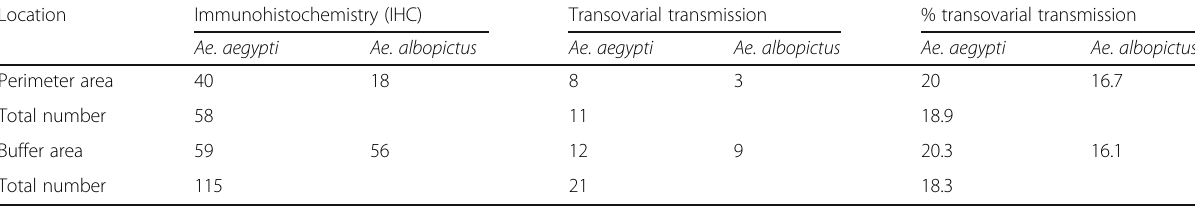
Table 2 Analysis of transovarial transmission of Aedes spp. mosquitoes in Adisucipto Airport of Yogyakarta